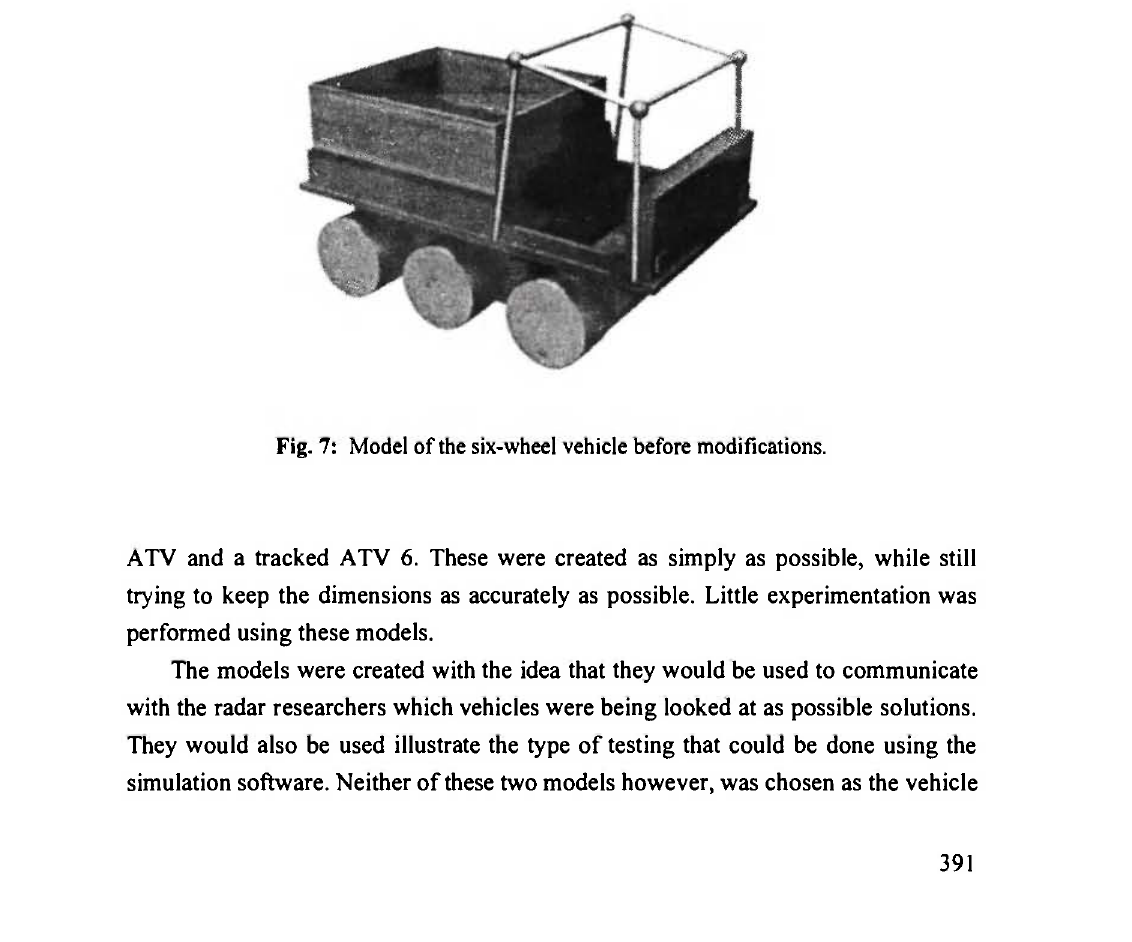
Fig. 6: Models of possible rover vehicles.